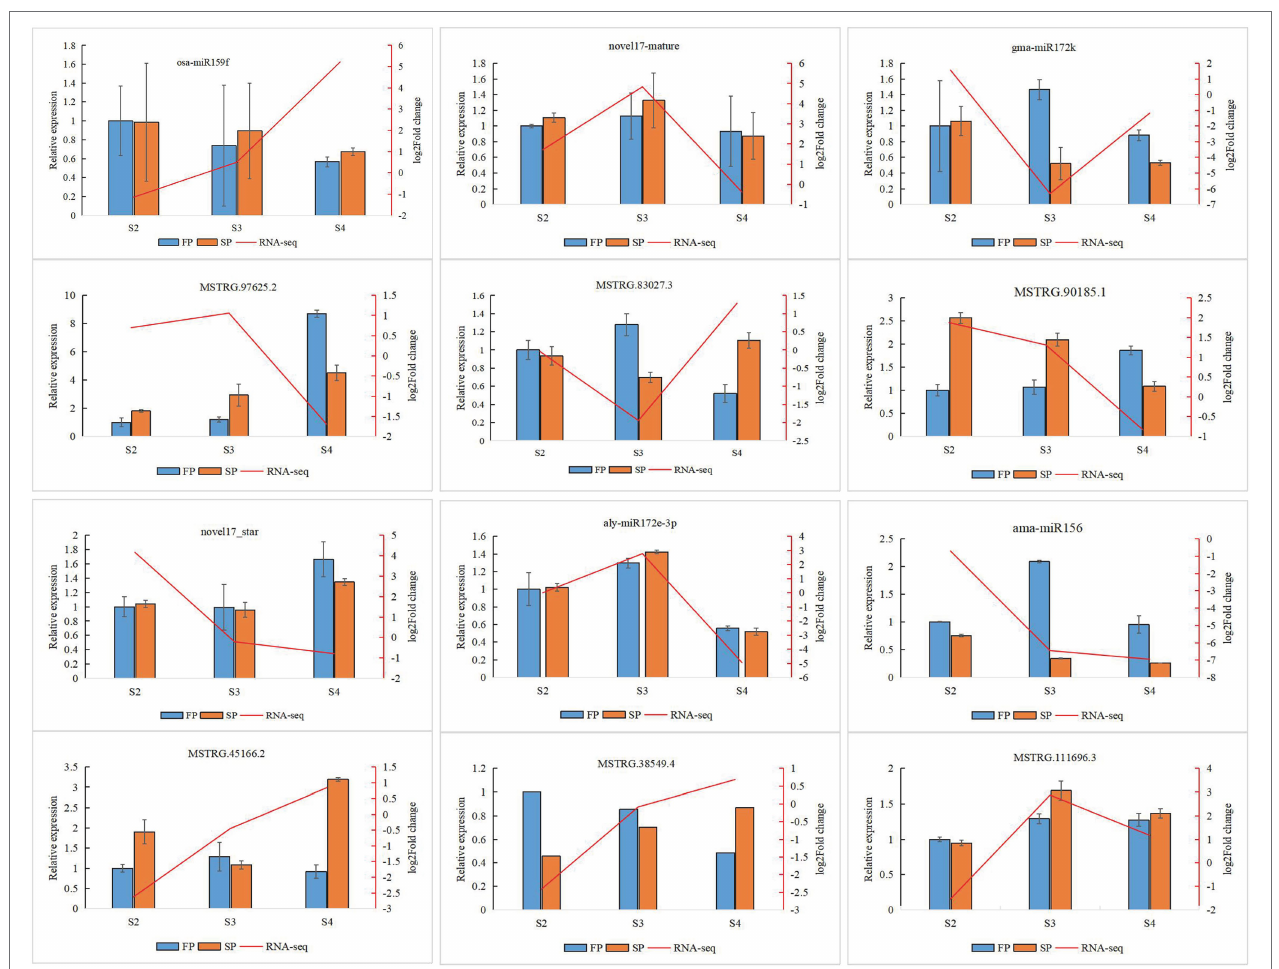
FIGURE 5 | Overview of miRNAs and genes regulation patterns in the patchouli response to continuous cropping. The red letters are upregulated genes or miRNAs, and the blue letters are downregulated genes or miRNAs. “ ⊥ ” stands for